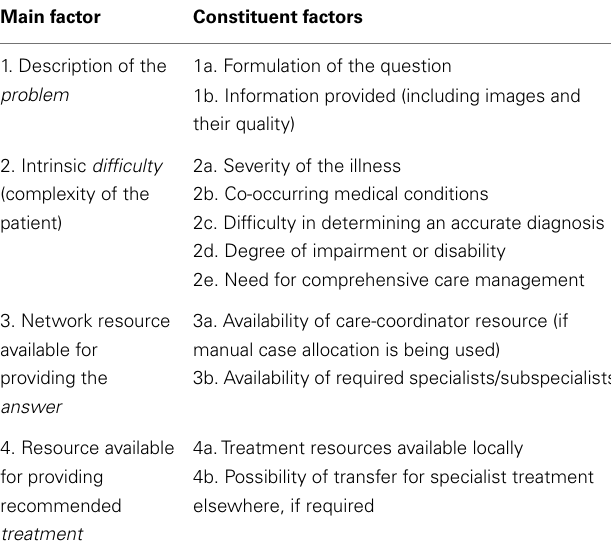
Table 1 | Summary of the factors affecting the difficulty of a case presented to a telemedicine network